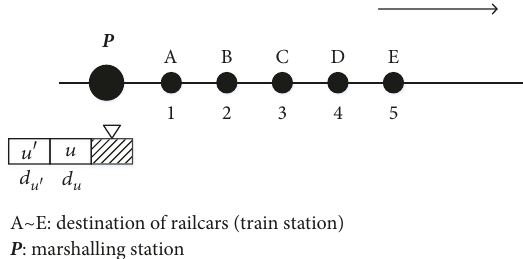
Figure 4: The definition of the destination sequence of the